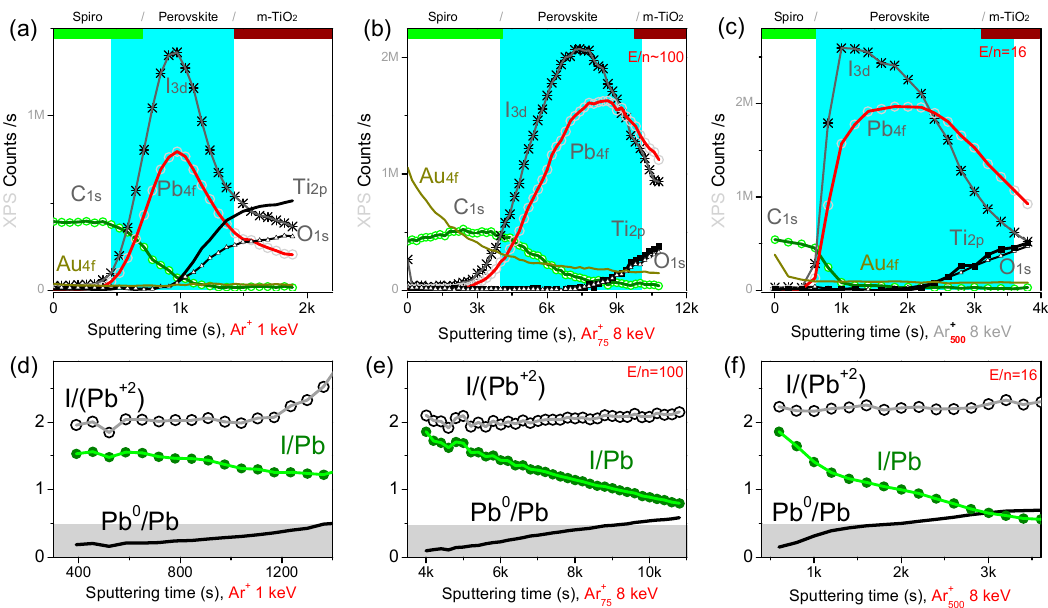
Figure 7. XPS depth profiles acquired on PSCs obtained with ( a,d ) monoatomic Ar + at 1 keV, ( b,e ) Ar 75+ clusters at 8 keV, and ( c,f ) Ar 500+ clusters at 8 keV. Bottom panels show atomic percent rations between iodide and lead which are present in two different chemical states (metallic Pb 0 and Pb +2 from the perovskite) in the perovskite area. The perovskite layer limits are roughly identified by the rise of the iodine and oxygen signals.